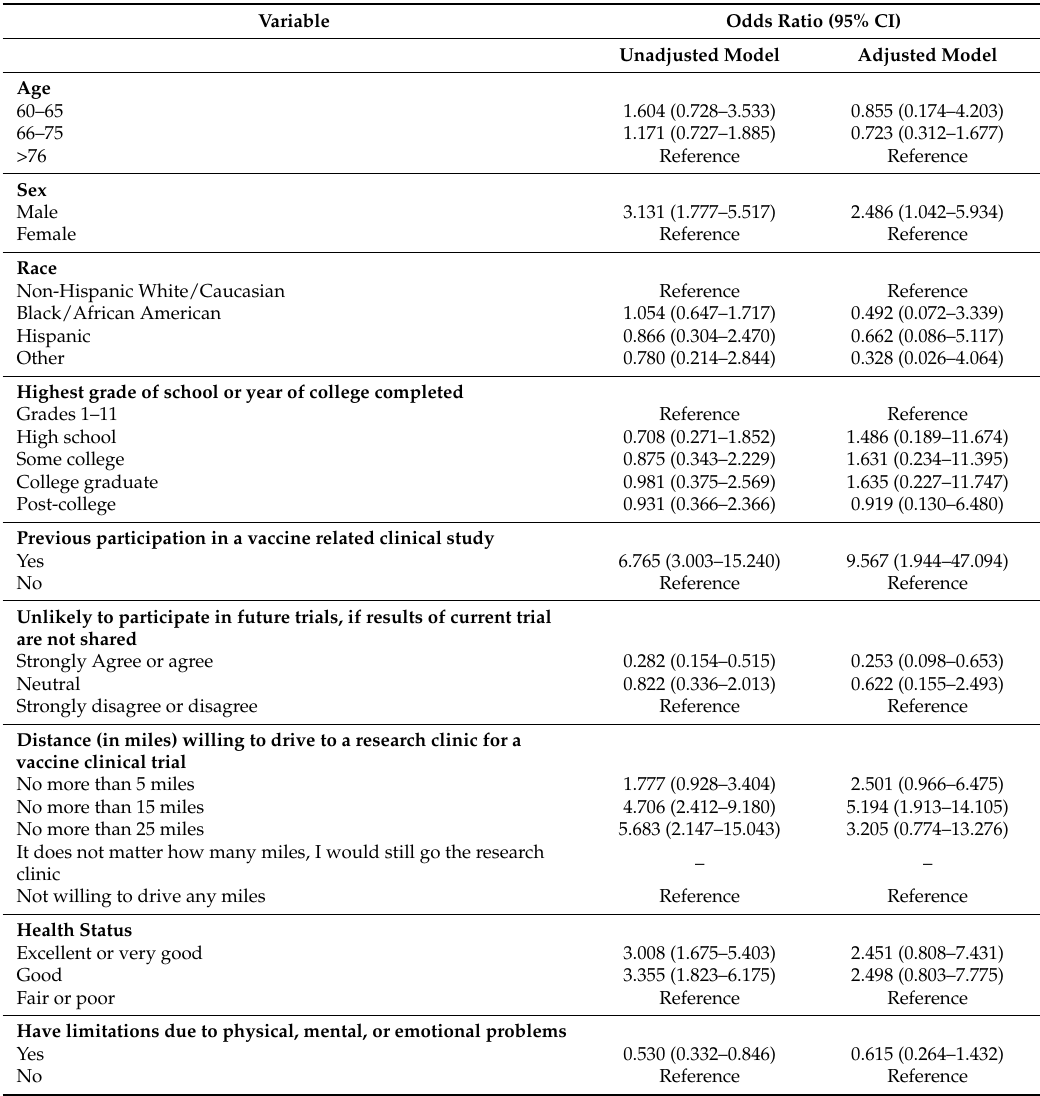
Table 3. Odds of willingness to participate in a vaccine study among adults 60 years of age or older, Metro-Atlanta, GA,